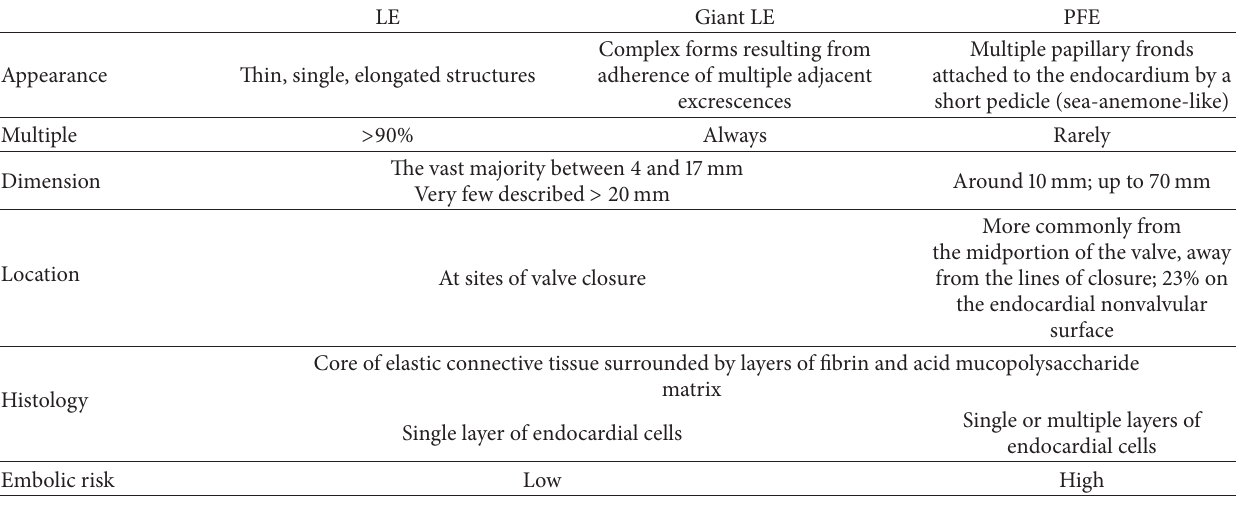
Table 1: Differences between LE, giant LE, and